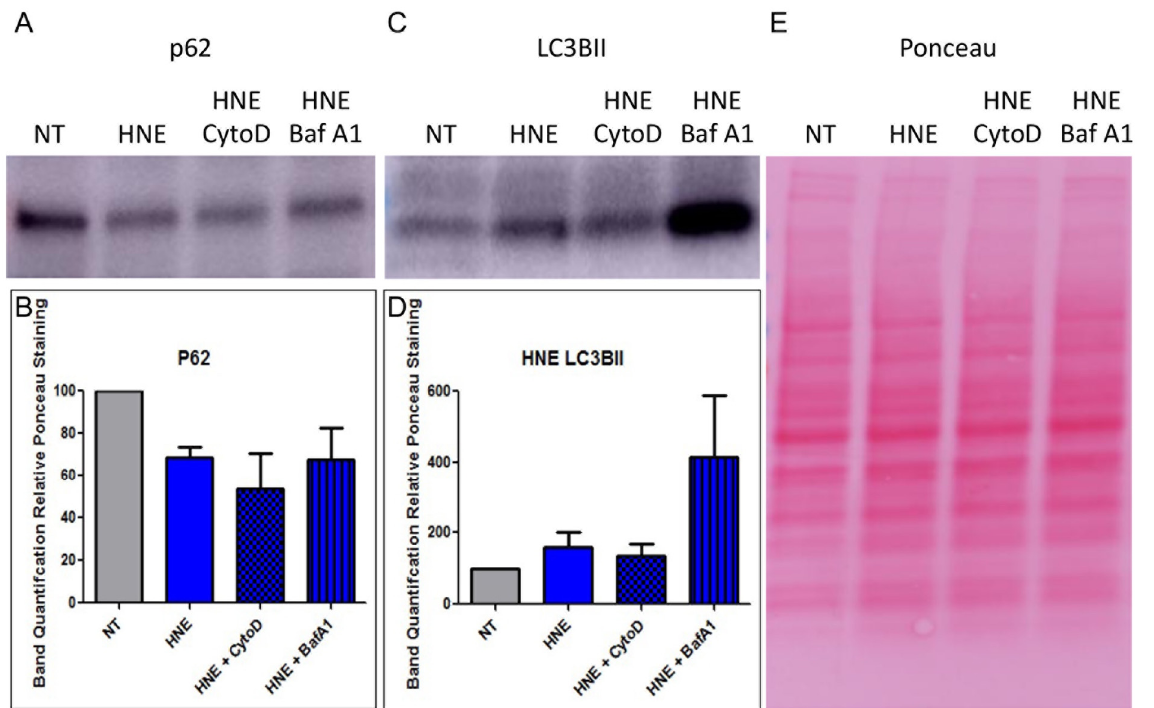
Figure 4. HNE treatment results in activation of autophagic flux in MDCK-CAR Ex8 cells. MDCK- CAR Ex8 cells were pretreated with cytochalasin D or bafilomycin A1 and subsequently treated with HNE. The MDCK-CAR Ex8 cells were then washed thoroughly before performing Western blotting on the samples. Representative Western blot data of ( A ) anti-p62-treated, ( C ) anti-LC3BII-treated blots, as well as ( E ) Ponceau staining are shown. Band quantifications of ( B ) p62 bands relative Ponceau staining and ( D ) LC3BII bands relative to Ponceau staining are shown. Error bars represent SEM from 3 independent experiments each performed in quadruplicate. NT, non-treated.